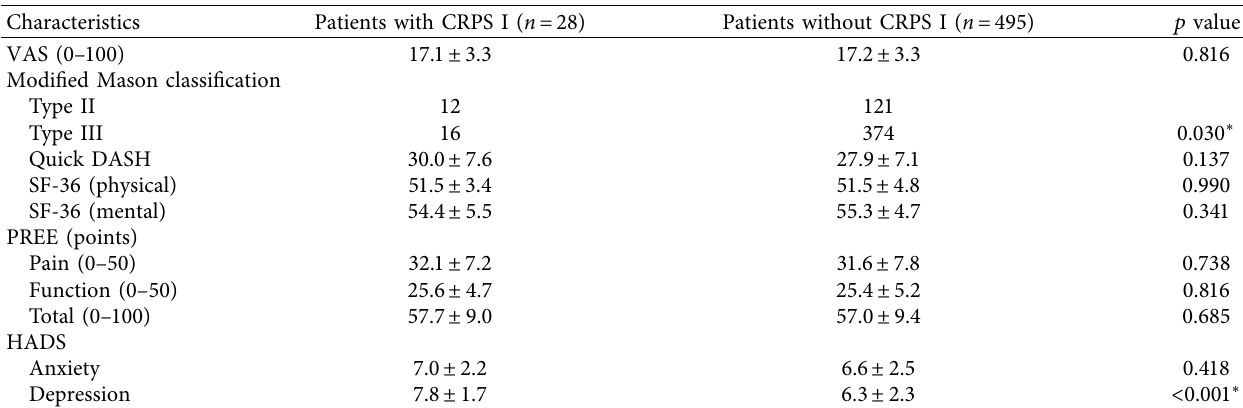
Table 4: Clinical characteristics of study sample